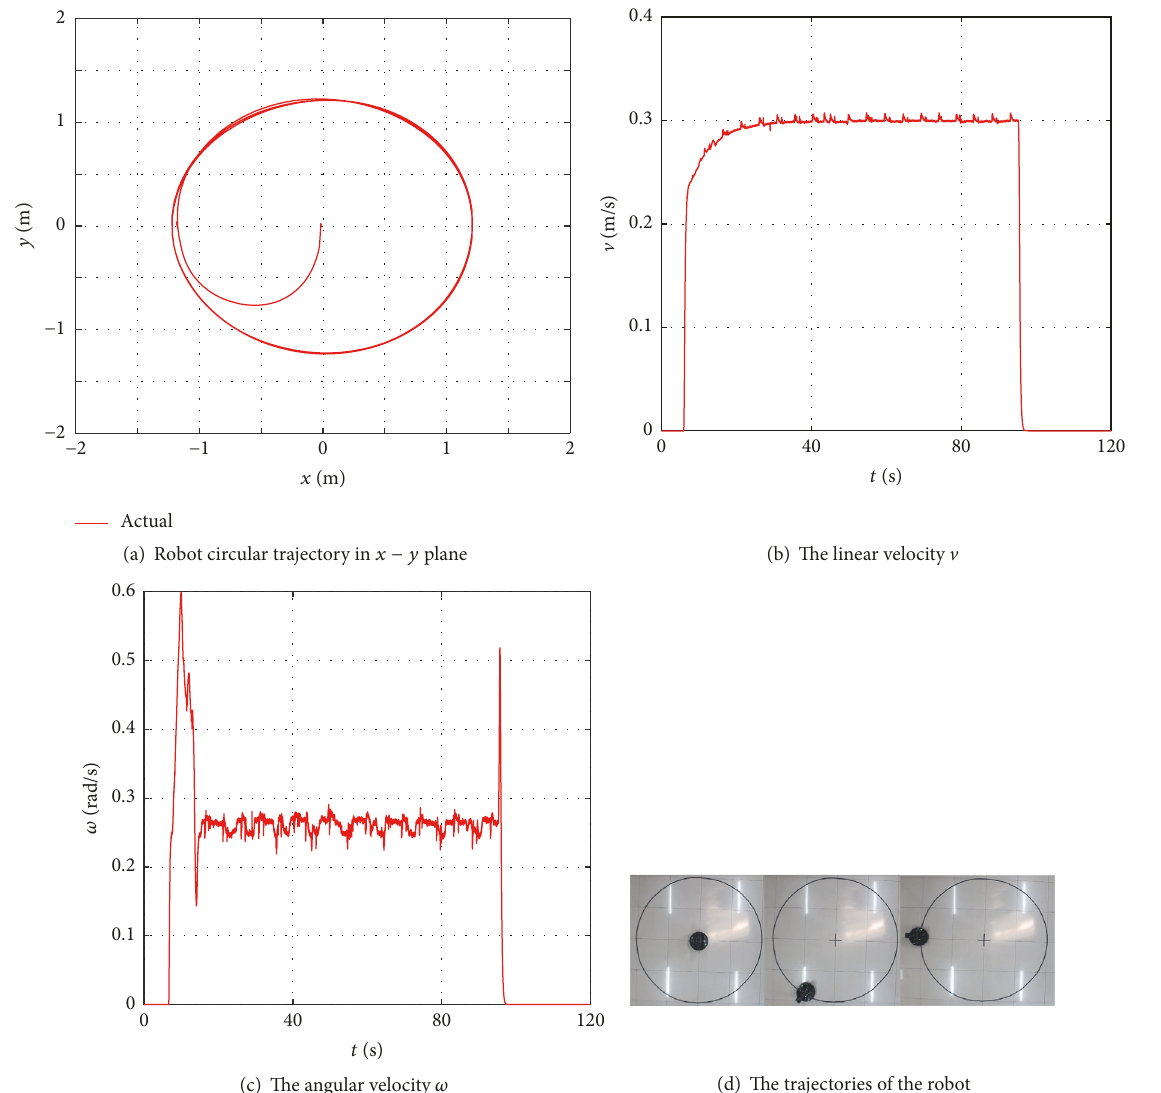
Figure 6: Experiment results of the mobile robot with the proposed